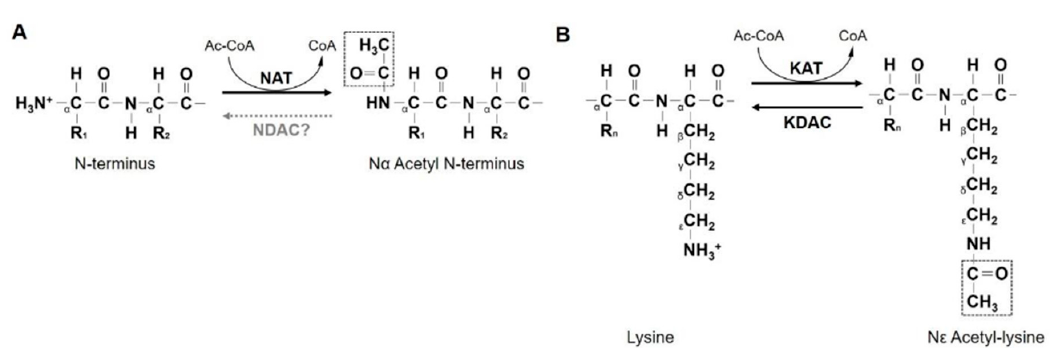
Figure 1. N-terminal and internal lysine acetylation by NAA10. ( A ) NAA10 acetylates the α -amino group of N-terminal residue of new peptides. An acetyl group (dotted rectangle) is transferred from acetyl-CoA to a free α -amino group at the N-terminal. ( B ) NAA10 also acetylates the ε -amino group of an internal lysine residue of the protein. The acetylated lysine can be deacetylated by the lysine deacetylase (KDAC), whereas N-terminal deacetylases (NDACs) have not been reported yet. NAT, N-terminal acetyltransferase; KAT, lysine acetyltransferase.